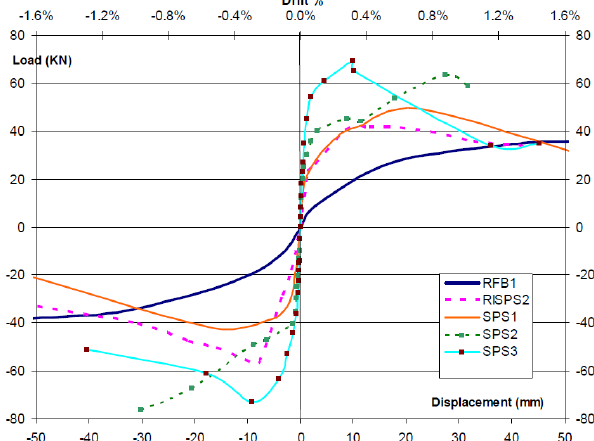
Figure 17 Comparison of envelope curves. Figure 19 Comparison of stiffness degradation. Table 3 Ultimate load and drift values with yield load and displacement values Ability of the structure to survive an earthquake depends on its ability to dissipate the input energy. The energy dissipation with hysteretic damping was determined by calculating the areas enclosed by the hysteretic load-displacement loops. An estimate of the dissipated energy can be found by the area inside the load-displacement hysteresis loops. The width of the loop also depends on the maximum cycle displacement. Since imposed displacements were not same for all specimens, energy dissipation values were normalized by dividing them to the corresponding cycle displacement. Cumulative energy values were evaluated by successive summation of the values. Figure 20 depicts the variation of cumulative dissipated energy as a function of cycle displacements. It may be noted that a wider loop (i.e. a large difference in ordinates in the ascending and the descending paths) would signify higher hysteretic damping.